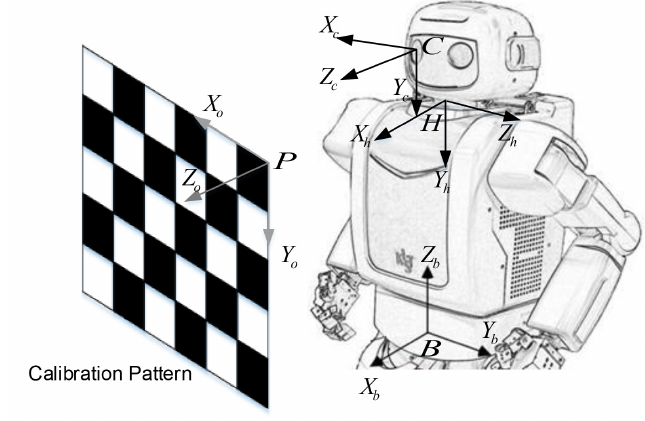
Figure 1. Setup for robot head-eye calibration and relevant coordinate frames: camera { C }, robot head (neck) { H }, robot base { B }, and calibration pattern { P